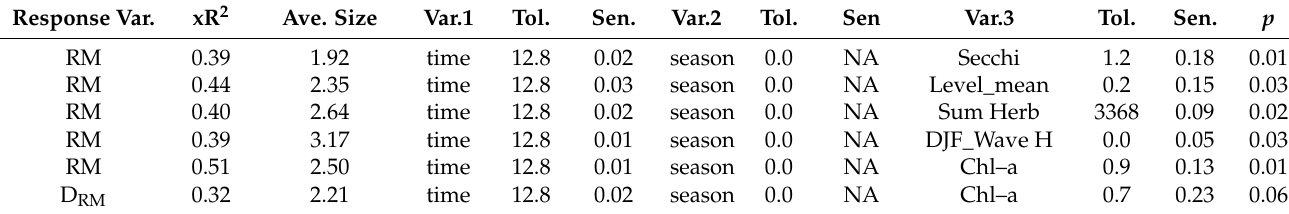
Table 4. Results of NPMR (nonparametric multiplicative regression) models for total macro- phytes (RM) and dense macrophytes (D RM ). No successful regressions were found for sparse macrophytes (S RM ). xR 2 = cross-validated R 2 ;